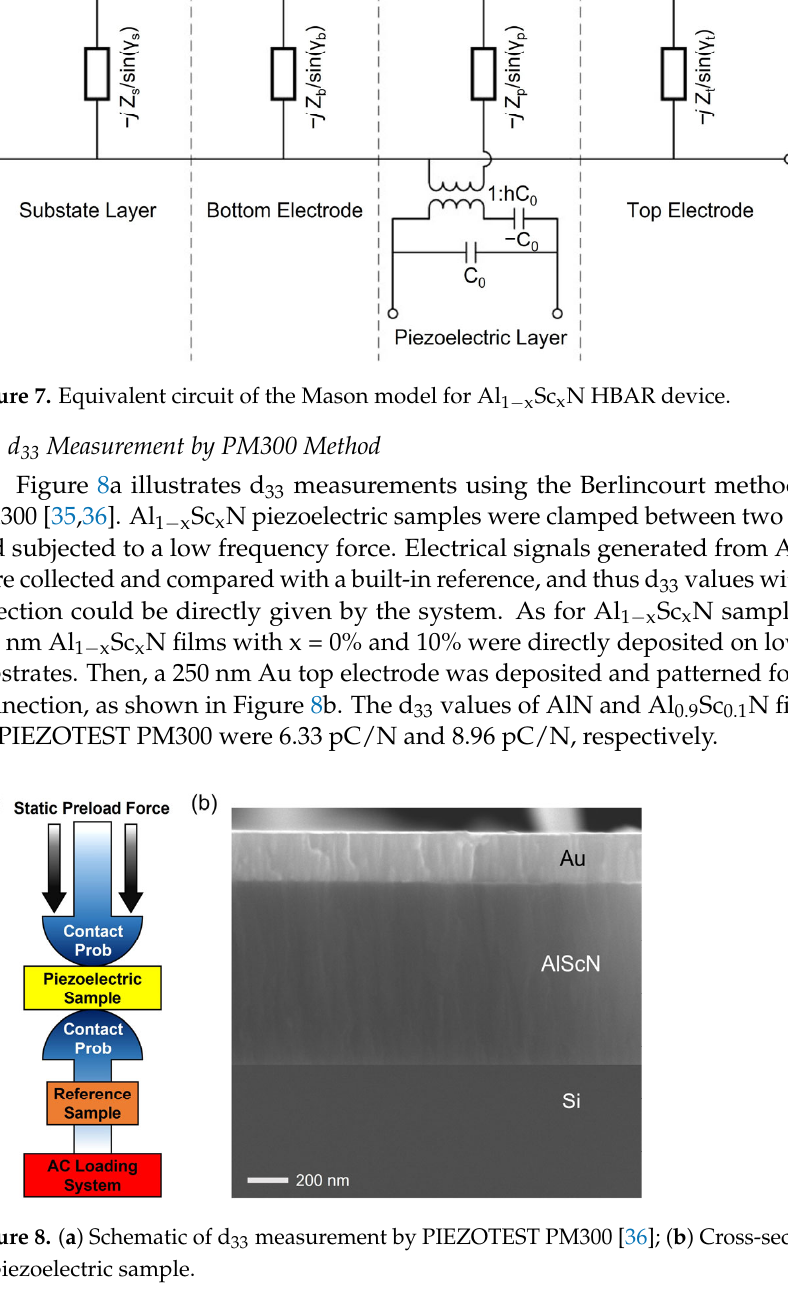
Figure 6. ( a ) Top ‐ view SEM image of Al 1 − x Sc x N HBAR device; ( b ) S 11 response of HBAR devices with AlN and Al 0.9 Sc 0.1 N films; Mason equivalent circuit fitting of ( c ) AlN and ( d ) Al 0.9 Sc 0.1 N on a 200 MHz span.